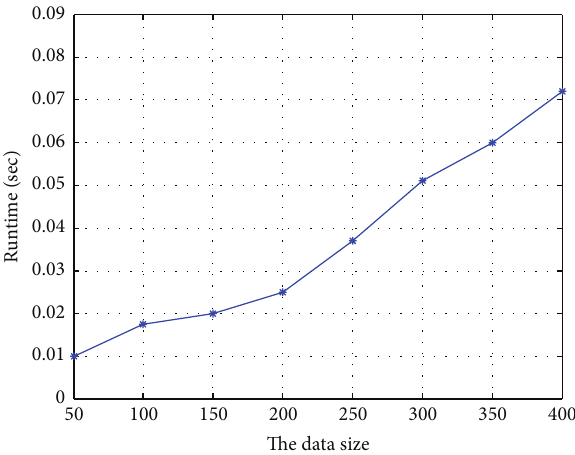
Figure 5: The runtime efficiency of our